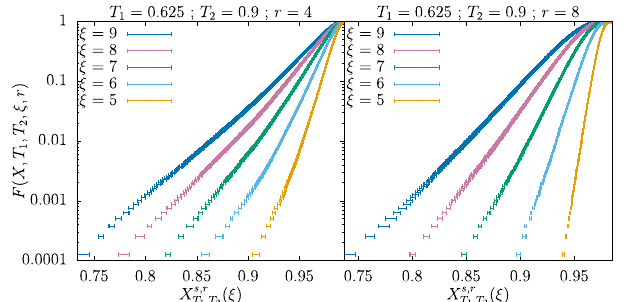
Fig. 3 Temperature chaos increases with the coherence length. The fi gure shows the distribution function F ( X , T 1 , T 2 , ξ , r ) for temperatures T 1 = 0.625 and T 2 = 0.9, for spheres of radius r = 4 and r = 8, as computed for various values of ξ . The distributions have been extrapolated to in fi nite number of replicas N Rep = ∞ , see Supplementary Note 1 for further details. Error bars, that represent one standard deviation, are horizontal, because we have actually extrapolated the chaotic parameter, which is its inverse function X ( F , T T ξ , r ). Most of the spheres have a chaotic parameter very close to 1 , 2 , X = 1 (absence of chaos). However, if we fi x our attention, for instance, on percentile 1 (i.e., F = 0.01) we see that the corresponding value of X decreases monotonically (and signi fi cantly) as ξ grows, signaling a developing chaotic effect. This trend is clear both for spheres of radius r = 4 and r = 8.